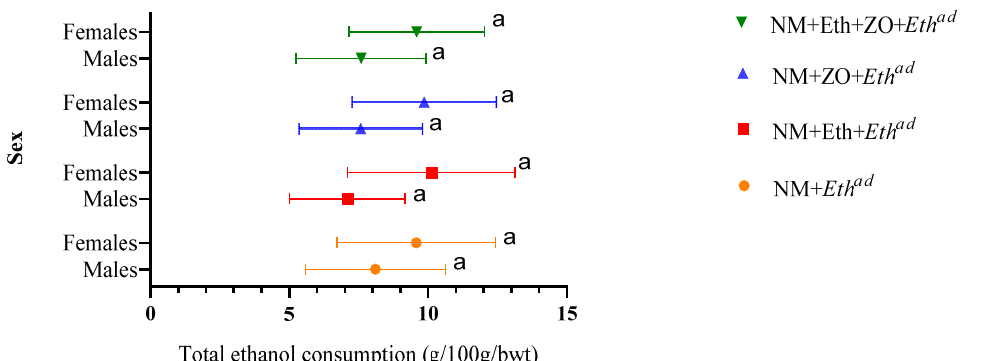
Figure 2. Effect of neonatal orally administered zingerone on ethanol consumption. Data are presented as mean ± sd. a,a = Line graphs with similar letters do not differ significantly at p > 0.05. Control (NM